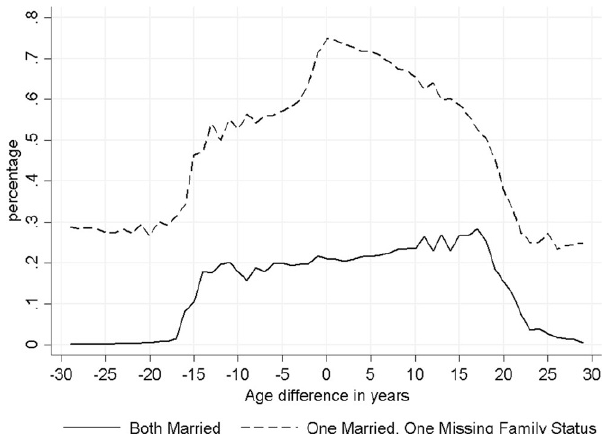
Fig. 7 Share of matched pairs listed as married-married or married- missing; 2 people at a coordinate. (Note: Includes all male-female pairs of individuals who we were able to match by location and name (ac- cording to our name-matching algorithm), and where at least one mem- ber has the family status variable filled in. Restricted to couples living at coordinates where exactly 2 people are located. Age difference